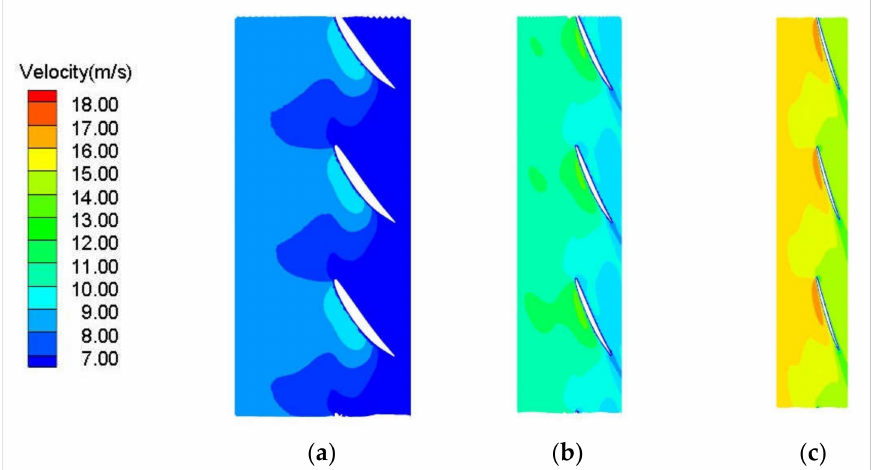
Figure 15. Velocity contour of each span in scheme I ( Q = Q des ). ( a ) Span = 0.1. ( b ) Span = 0.5. ( c ) Span = 0.9.